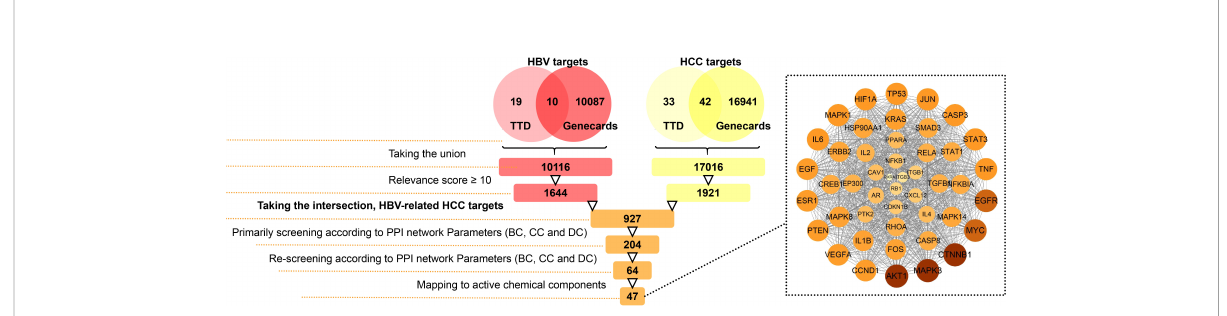
FIGURE 2 Procedure of searching and screening for HBV-associated HCC targets, which were derived by taking the intersection of HBV targets and HCC targets. Protein-protein interactions amongst the 47 targets were in the dashed box